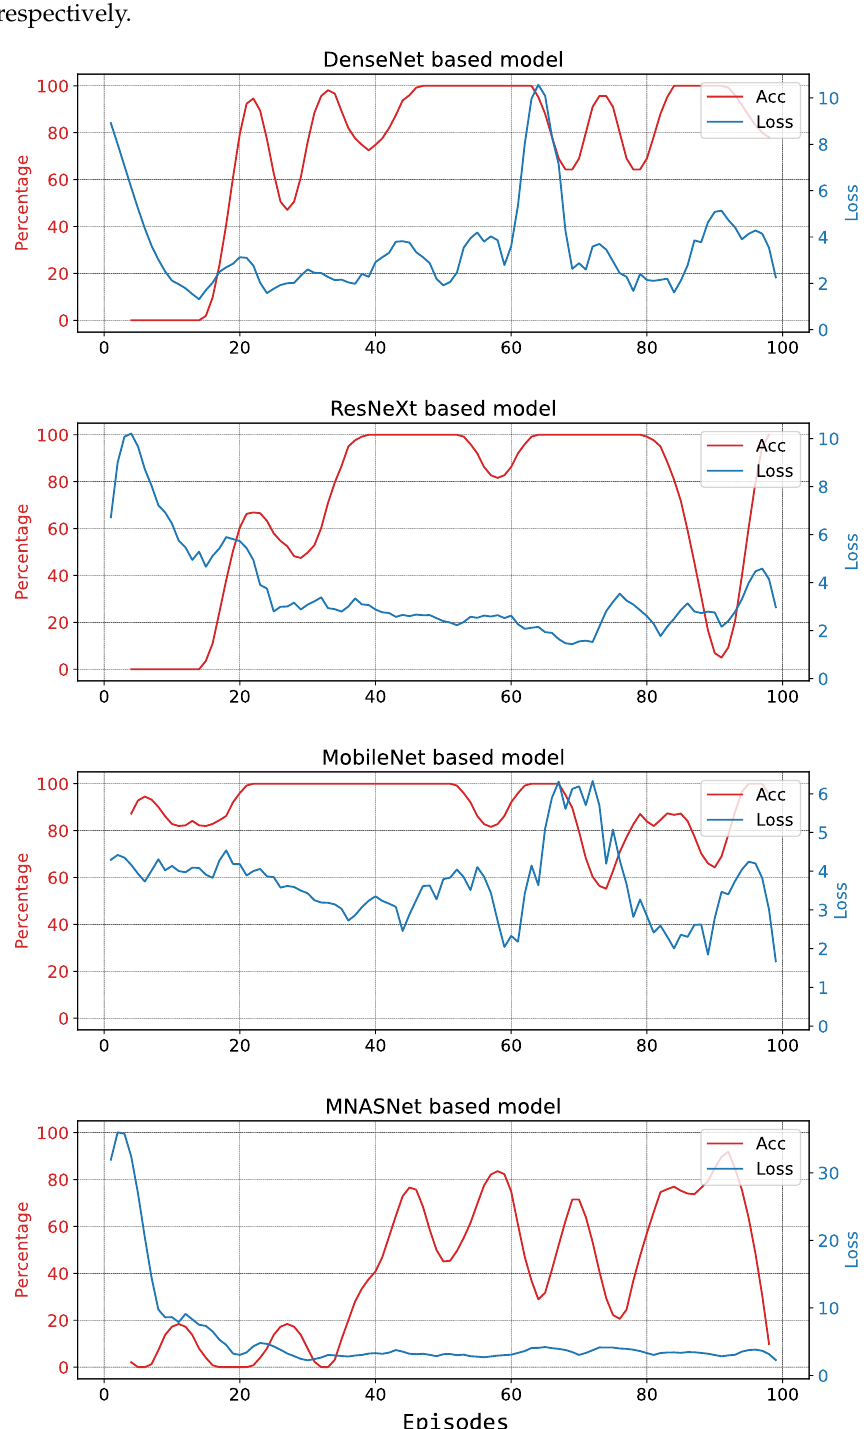
Figure 10. Evolution of loss (blue) and accuracy (red) of the system during 100 episodes of the second testing session on a real robot. Data was smoothed using a third order